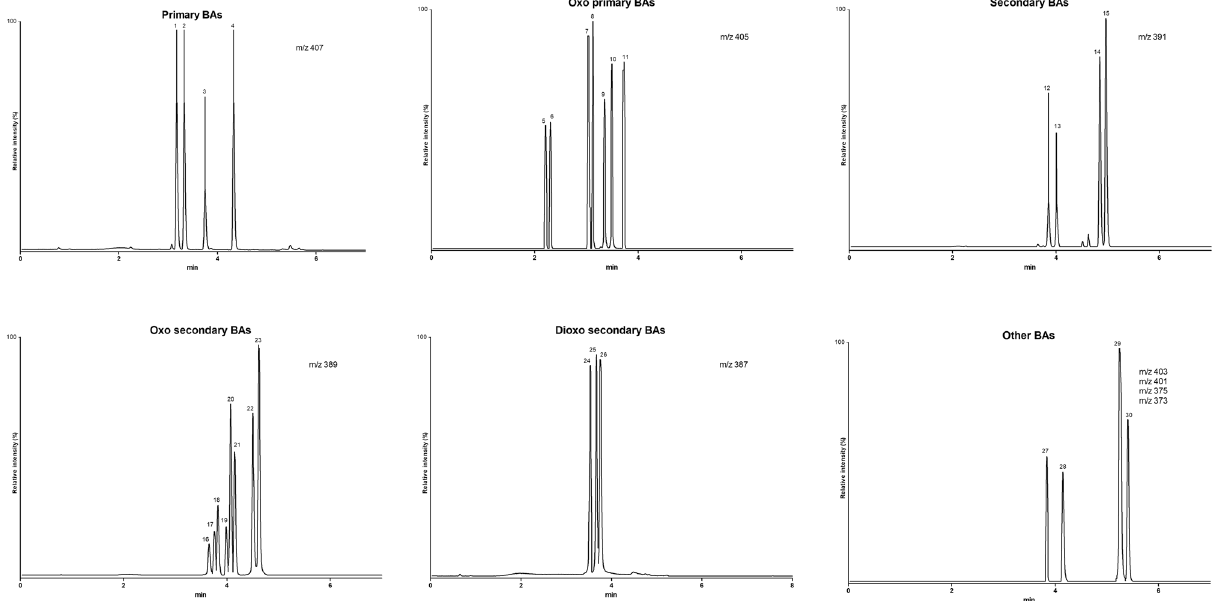
Figure 2. Chromatograms of the investigated BAs and oxo derivatives. 3α,6β,7α-trihydroxy-5β-cholan- 24-oic acid (1), 3α,6β,7β-trihydroxy-5β-cholan-24-oic acid (2), 3α,6α,7α-trihydroxy-5β-cholan-24-oic